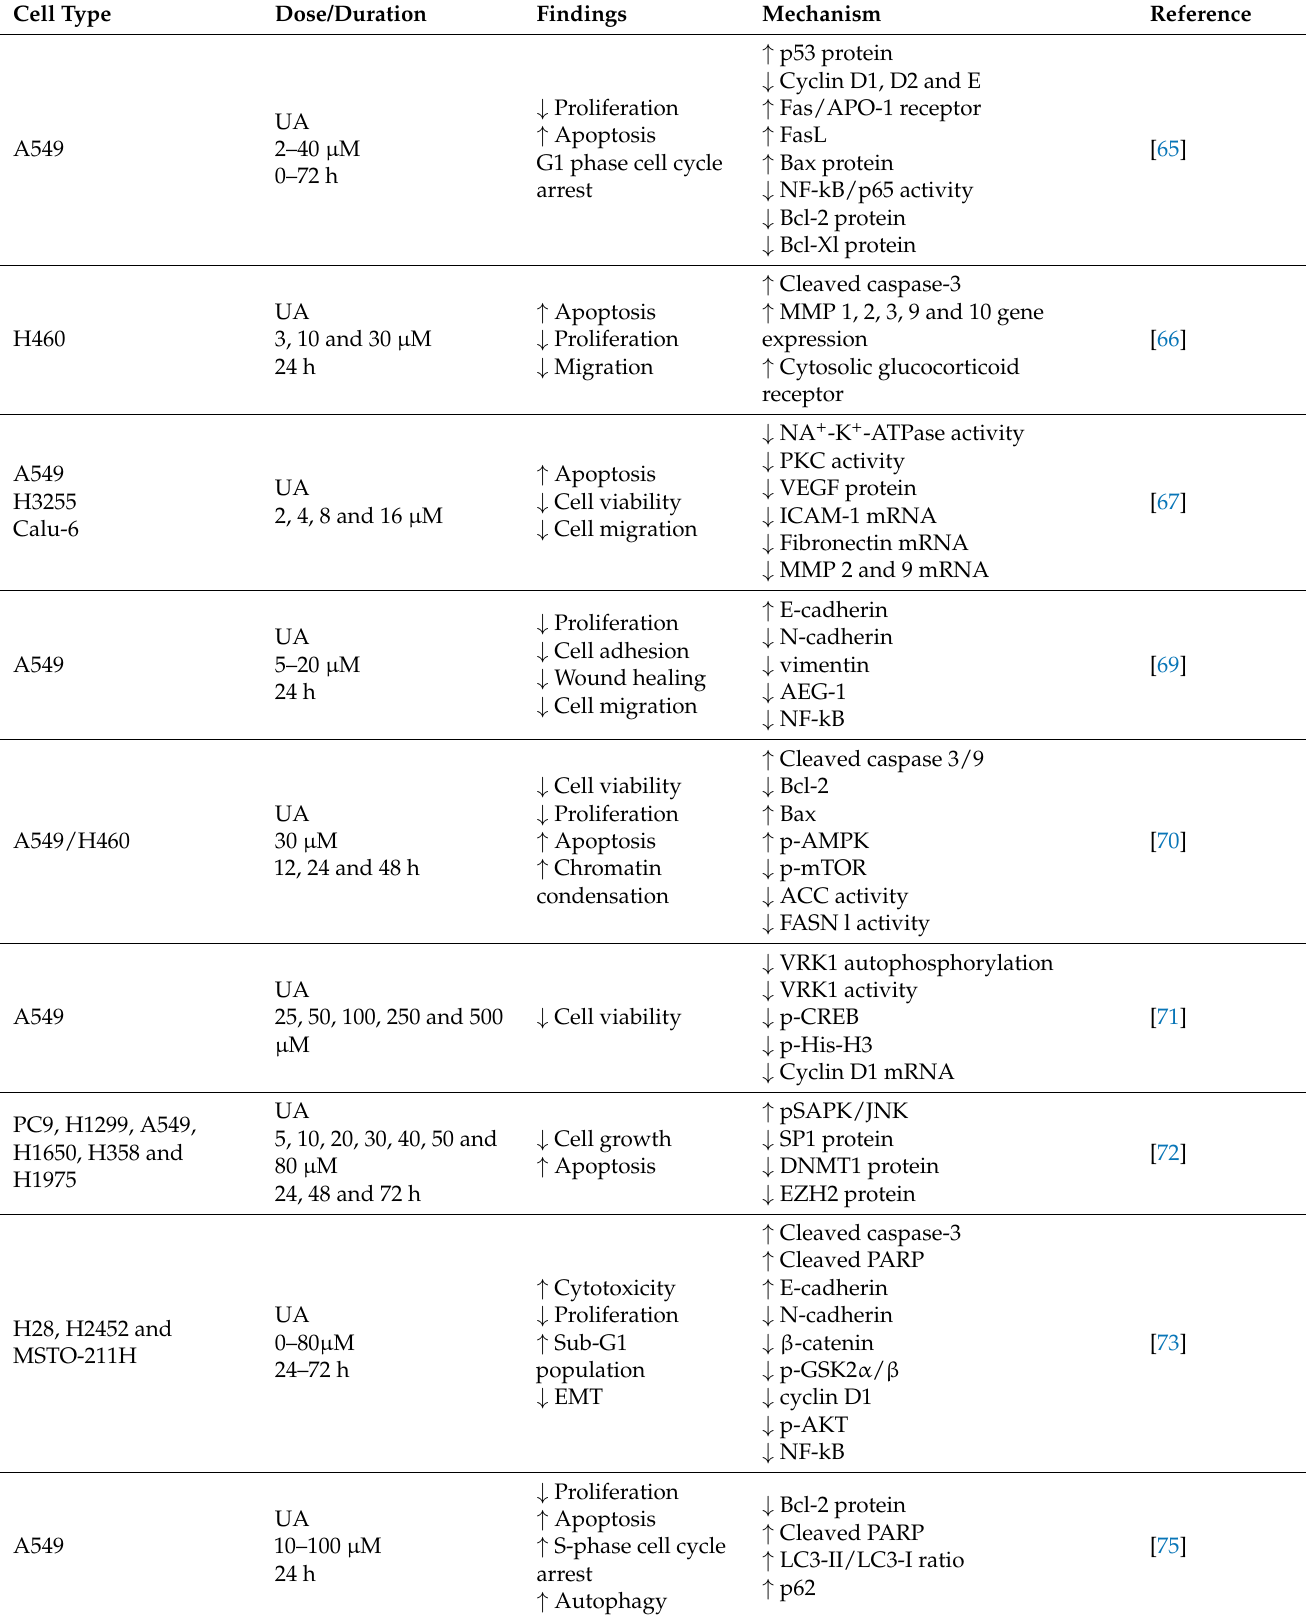
Table 2. Evidence of the effects of ursolic acid in lung cancer cells: a summary of in vitro